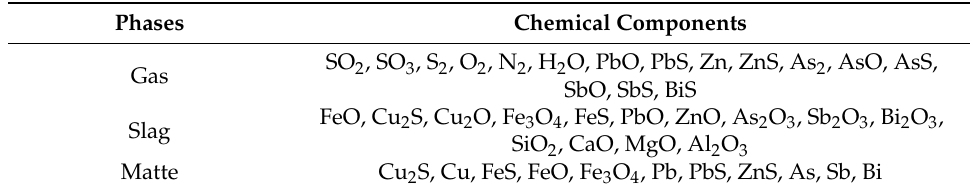
Table 1. Chemical components in the SKS (Shuikoushan) copper smelting